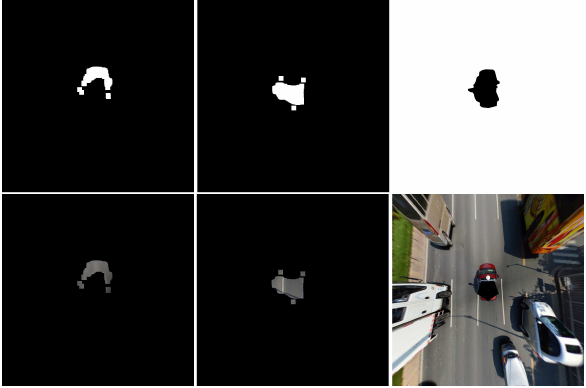
Figure 5. An illustration of the optimal label map (Left) and its correspondingly completed image region at the bottom of a streetview panorama.